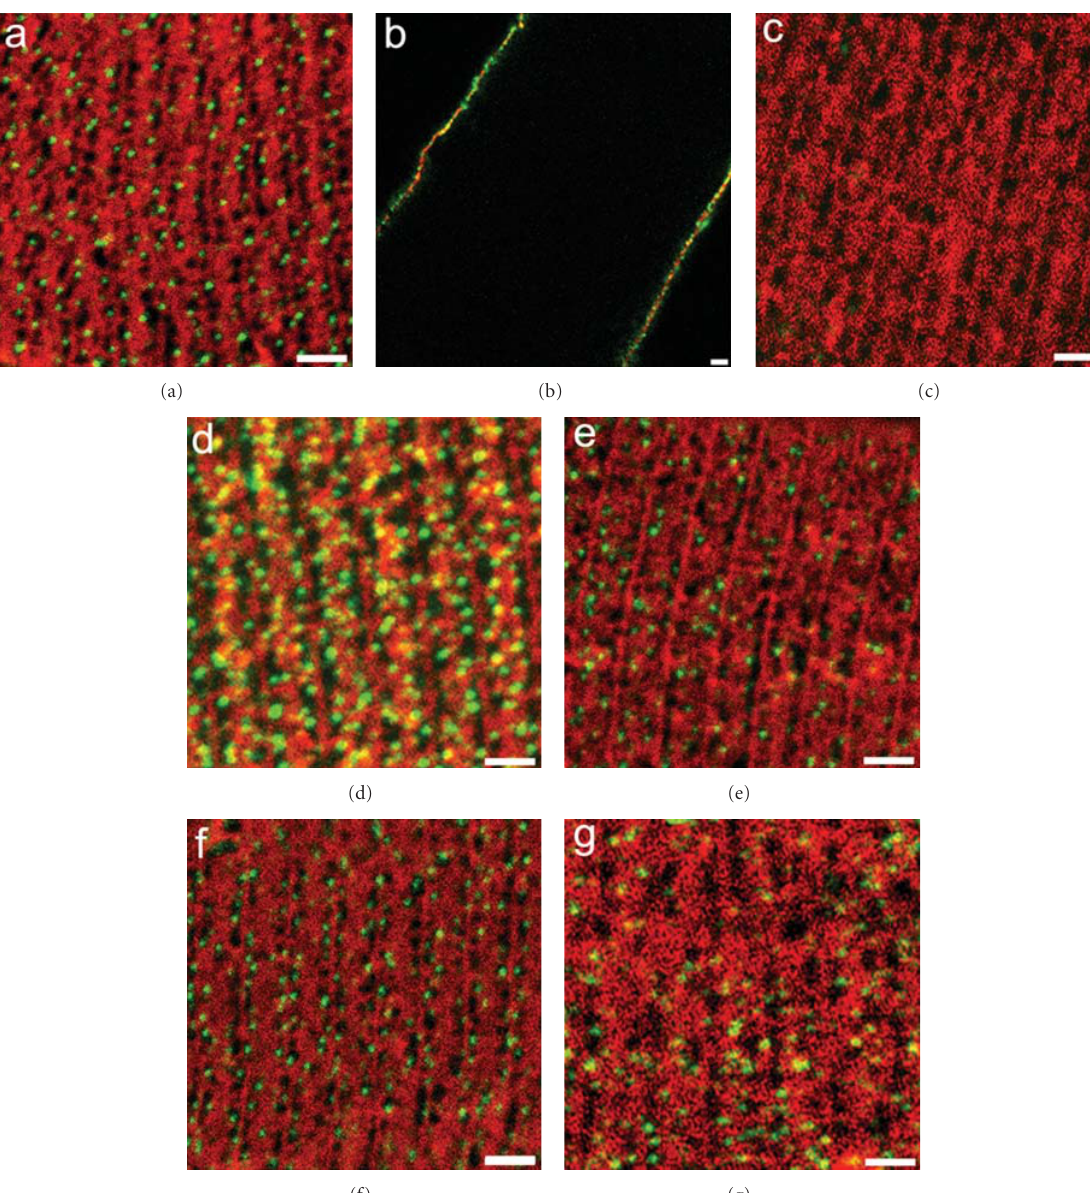
Figure 6: HA localizes to the DGC-deficient domains independently of raft association. Double immunofluorescence staining for the sarcolemmal wild-type HA (green) and β -dystroglycan (red) is shown at the sarcolemma level (a) and at the middle of the fiber (b). Double immunofluorescence staining for a noninfected control shows no HA (c). At high expression level, HA occupies regions of β -dystroglycan (DGC-rich domain) (d). Treatment with 5 mM CDX does not change the distribution pattern of wild-type HA and β -dystroglycan (e). The distribution pattern of the nonraft-associated mutant HA lacking the palmitoylation sites and transmembrane raft-targeting signals also remained unchanged as shown by double staining for β -dystroglycan (f). Primary antibody incubation was performed at 10–12 ◦ C for 1.5 h before the fixation with 3% paraformaldehyde (a–f). Fixation of the myofiber before application of the anti-HA antibodies did not change the distribution pattern (g). The pictures have undergone brightness and contrast adjustment. Scale bar, 2 μ